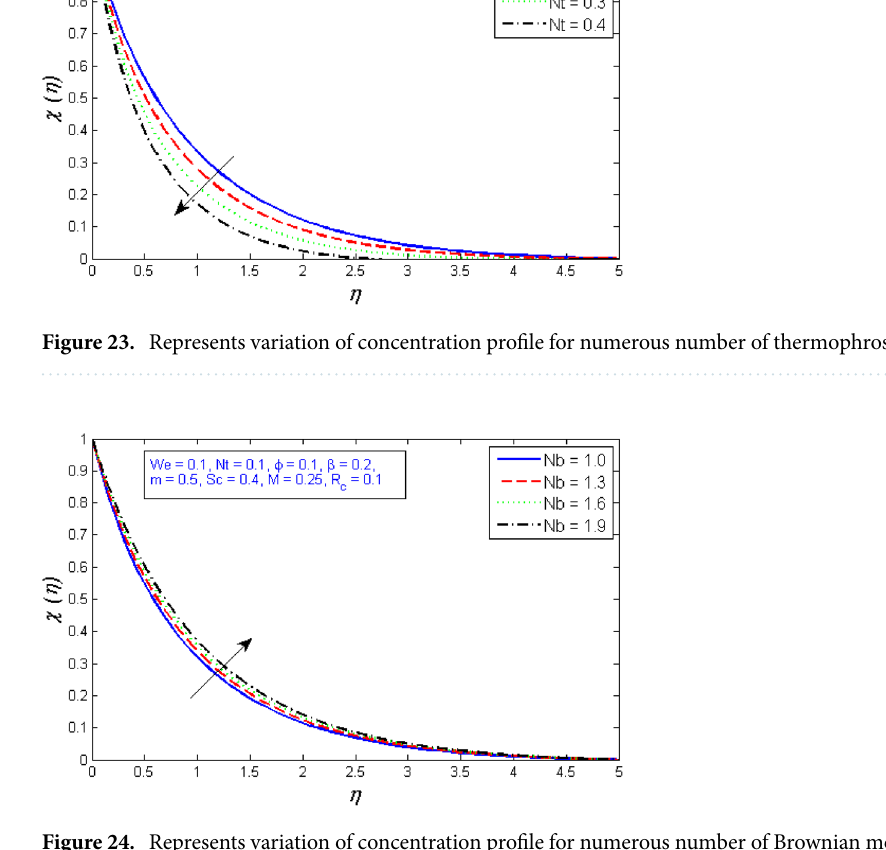
Figure 24. Represents variation of concentration profile for numerous number of Brownian motion Nb